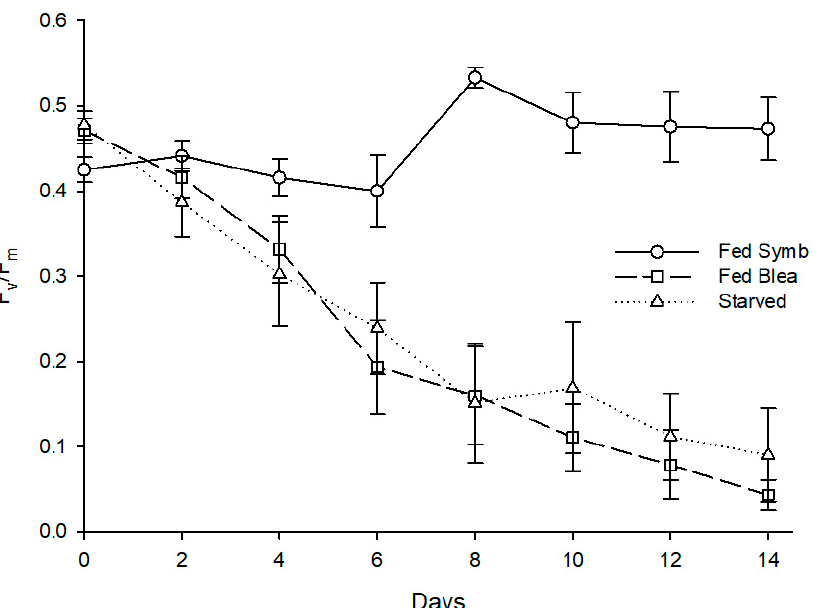
Figure 7. Evolution of fluorescence parameter F v /F m in photosynthetic dinoflagellate endosymbionts hosted by Berghia stephanieae when exposed to different diets (mean ± std. error, starting n = 10). Fed Symb—fed with symbiotic anemones ( Exaiptasia diaphana ), Fed Blea—fed with bleached anemones.